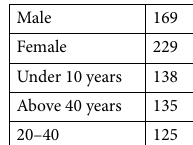
Table 1. Prevalence of iron deficiency among northern Asir Region residents according to gender and